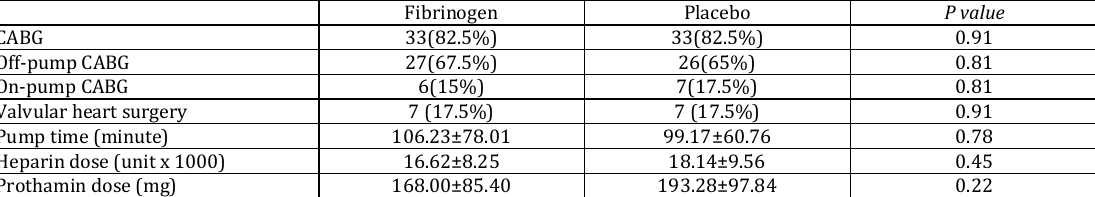
Table 2. Surgical data of patients undergoing cardiac surgery in fibrinogen and control group.